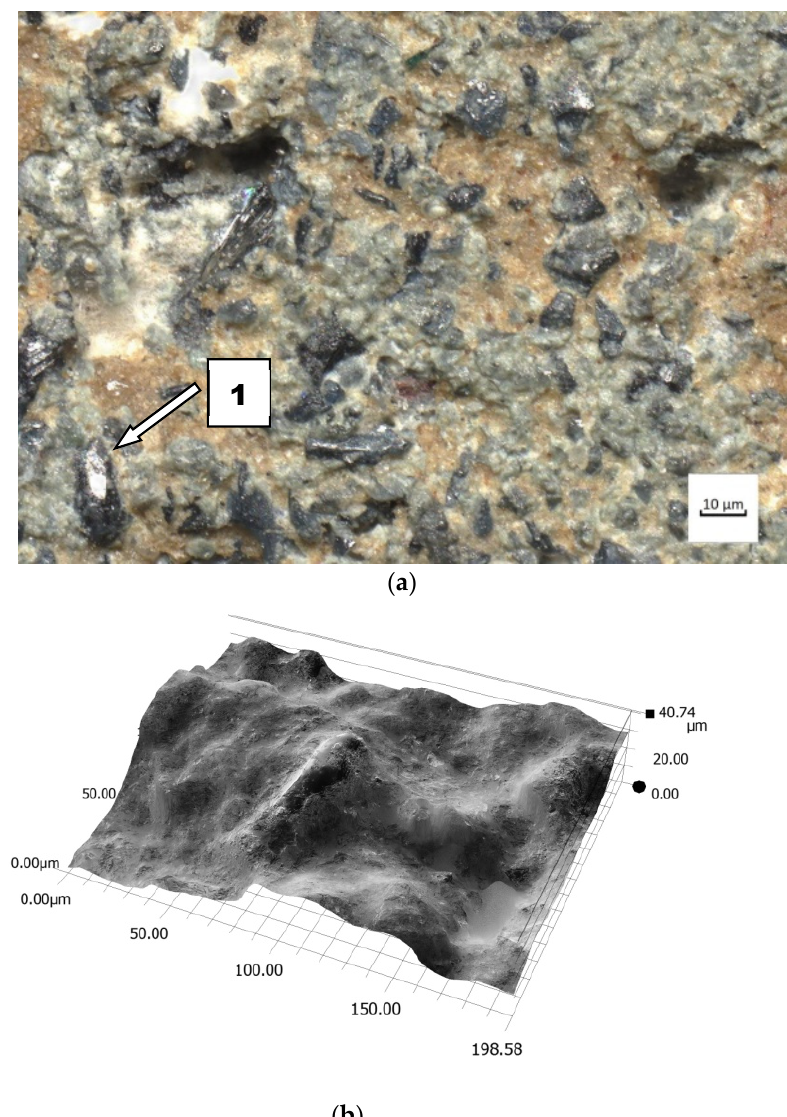
Figure 12. The friction surface condition after wear in medium soil: ( a ) view of coated grains of silicon carbide, magnitude 500×, (1) carbide grains before removal; ( b ) friction surface profile.